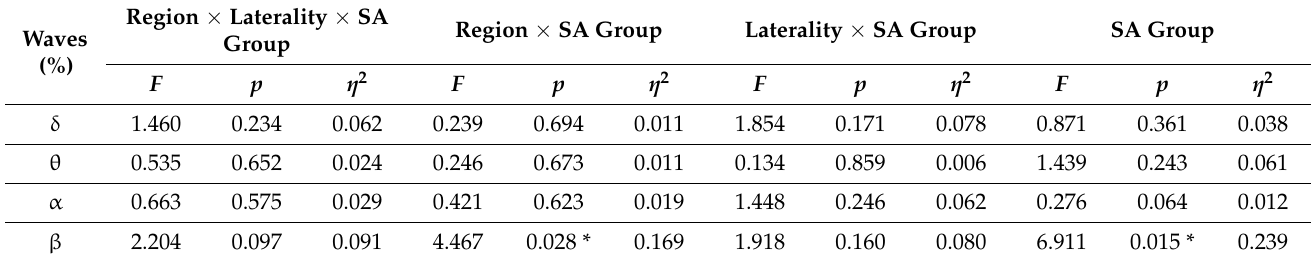
Table 2. ANOVA results of relative power for the two SA groups.